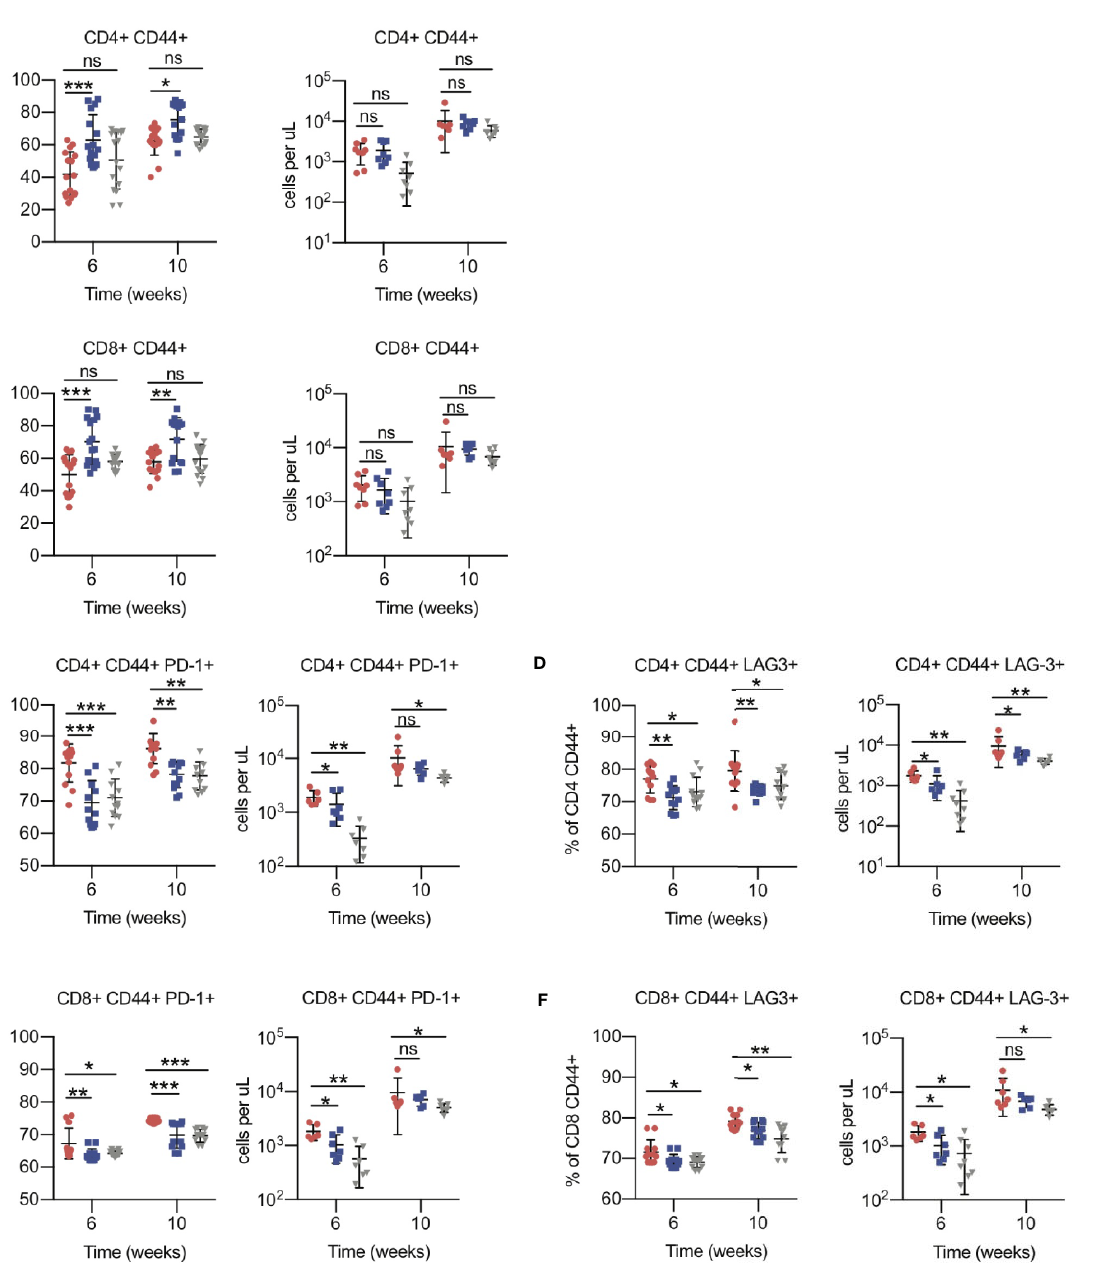
JAK2 protein was decreased over time in OSU-CLL cells treated